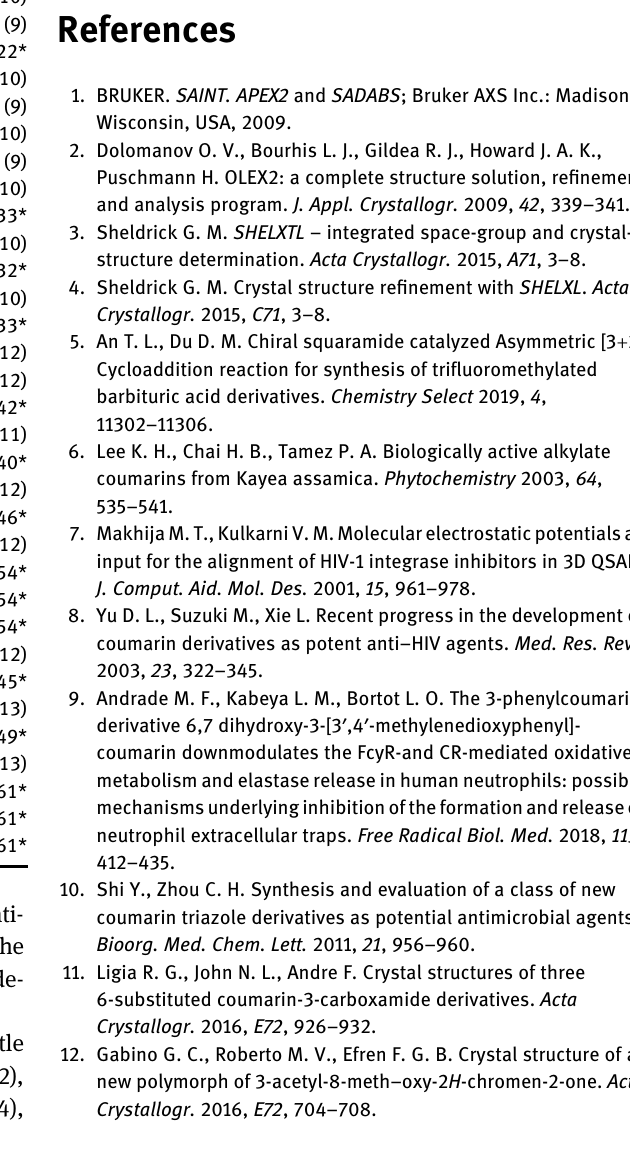
The title structure is shown in the figure. In the title